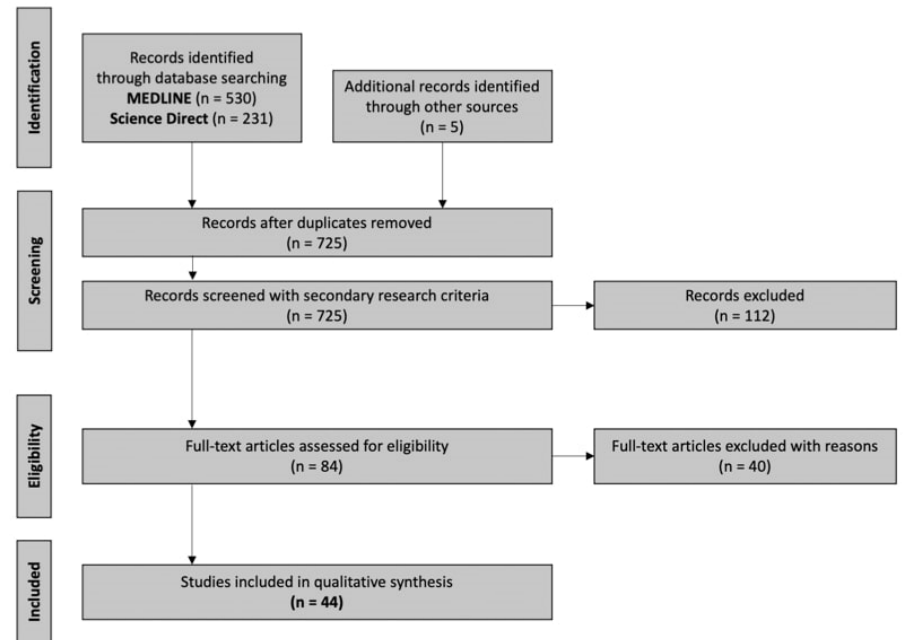
Figure 3. Study flow chart (PRISMA diagram).